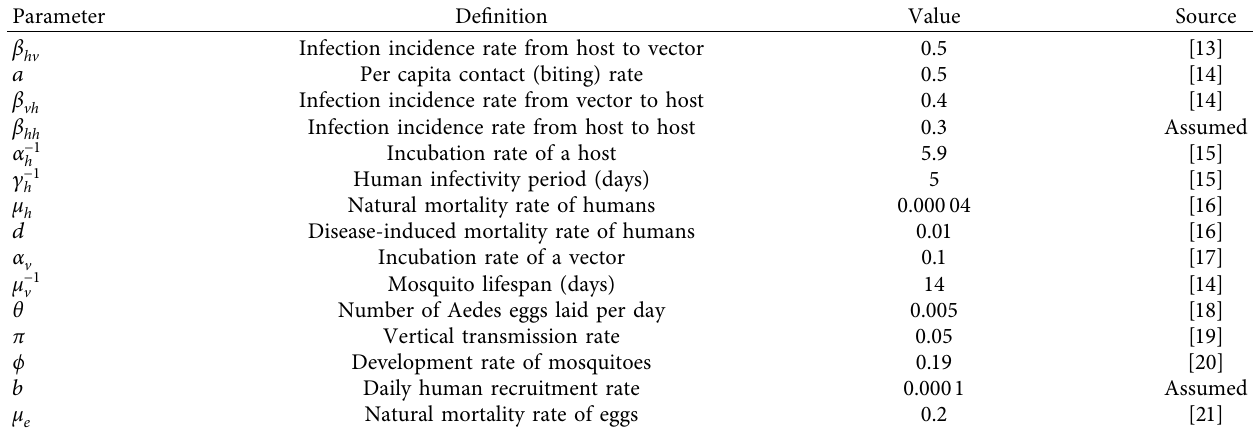
Table 1: Values of parameters used in the model, and the sources used for the numerical